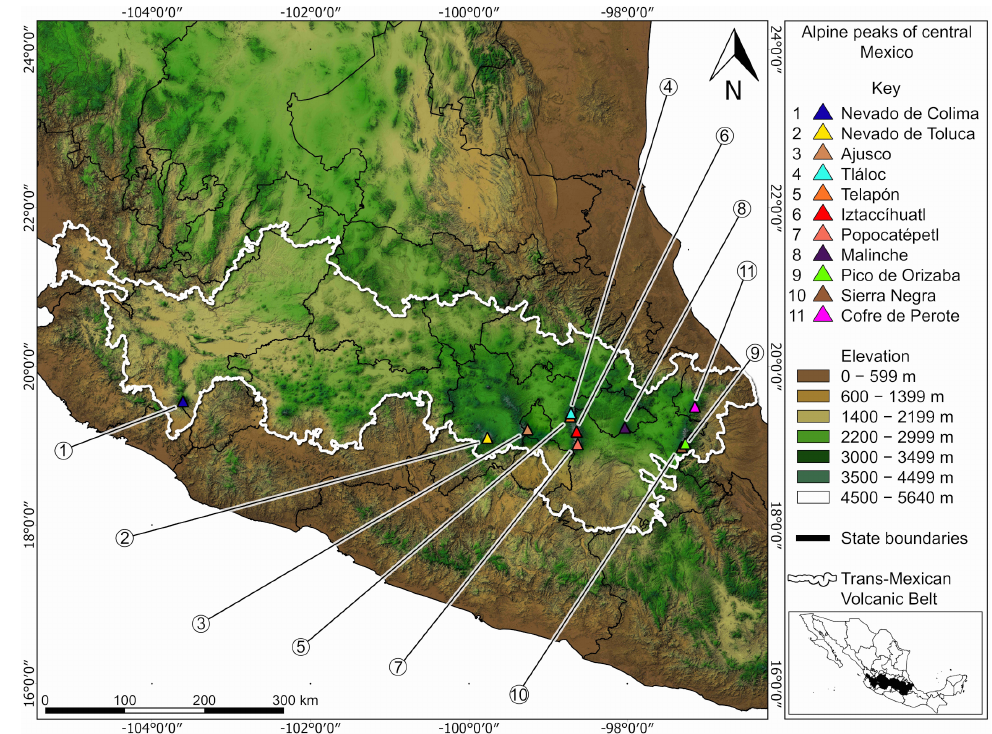
Figure 1. Map of the Trans-Mexican Volcanic Belt of central Mexico showing the location of the volcanoes with alpine vegetation at their